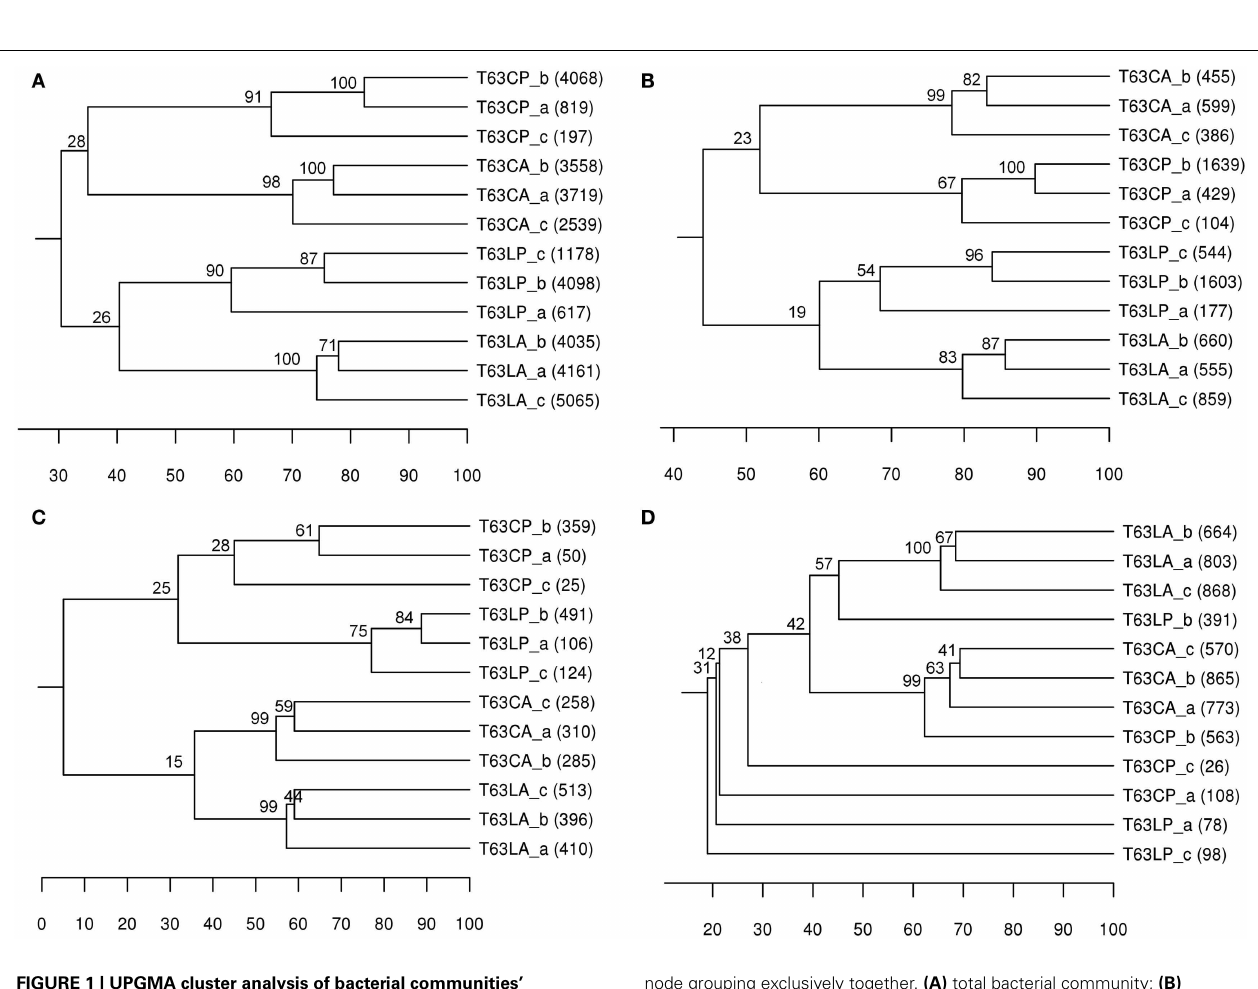
FIGURE 1 | UPGMA cluster analysis of bacterial communities’ structure based on Pearson correlation using OTUs ( > 97% sequence similarity) as the species data. Number in brackets: number of sequences obtained for the sample. Numbers on node: Bootstrapping value for each node means the percent frequency of all samples under the